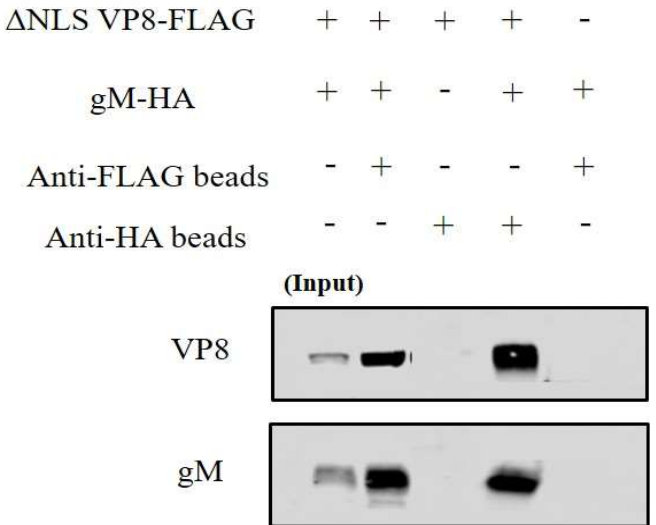
Figure 4. VP8-FLAG and gM-HA interact with each other in co-transfected cells. EBTr cells were co-transfected with ∆ NLS VP8-FLAG and pgM-HA, or with ∆ NLS VP8-FLAG or pgM-HA, and the lysates were incubated with anti-FLAG or anti-HA beads. After elution by SDS loading dye, the samples were subjected to SDS-polyacrylamide gel electrophoresis on an 8% gel and transferred to 0.45 µm nylon membranes. A fraction of the whole cell lysates was used as input control. VP8-FLAG and gM-HA were detected with monoclonal anti-FLAG and anti-HA antibodies, respectively, fol- lowed by IRDye 680RD goat anti-mouse IgG.